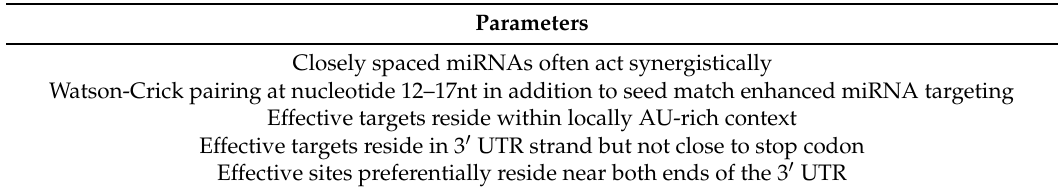
Table 1. Parameters for the identification of miRNA